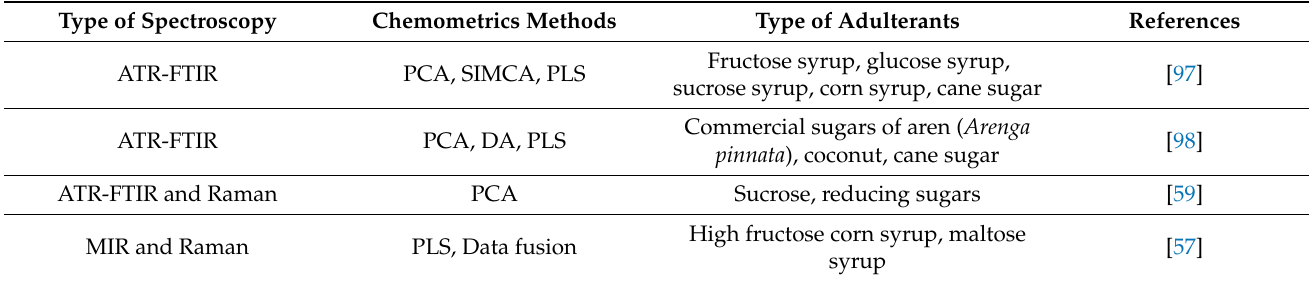
Table 2. Application of vibrational spectroscopic techniques coupled with chemometrics in detection of honey adulteration. Type of